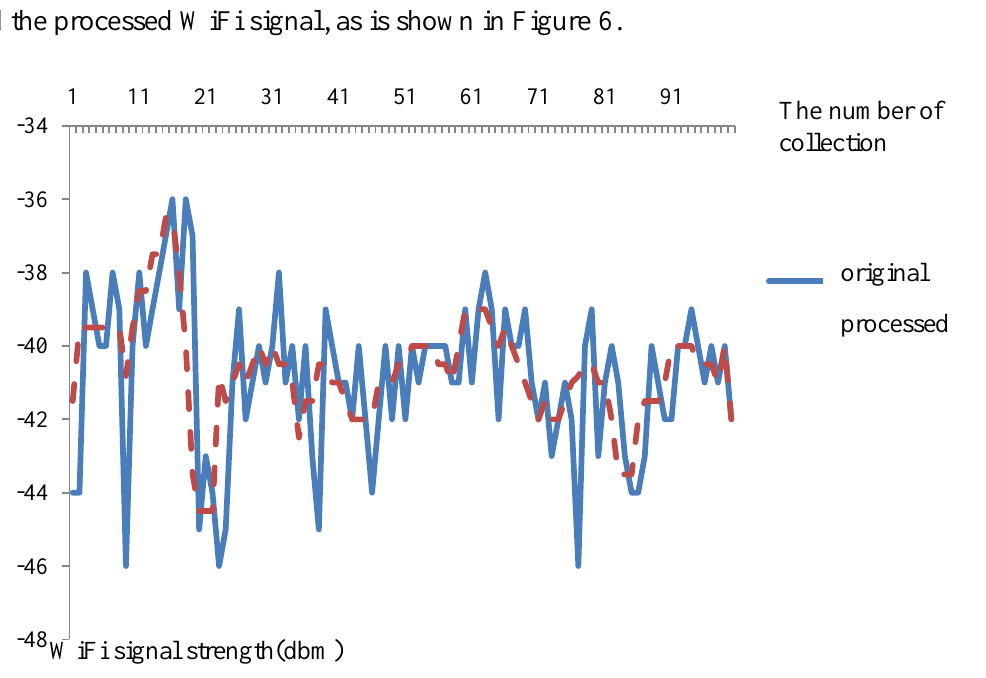
Figure 6. WiFi signal error